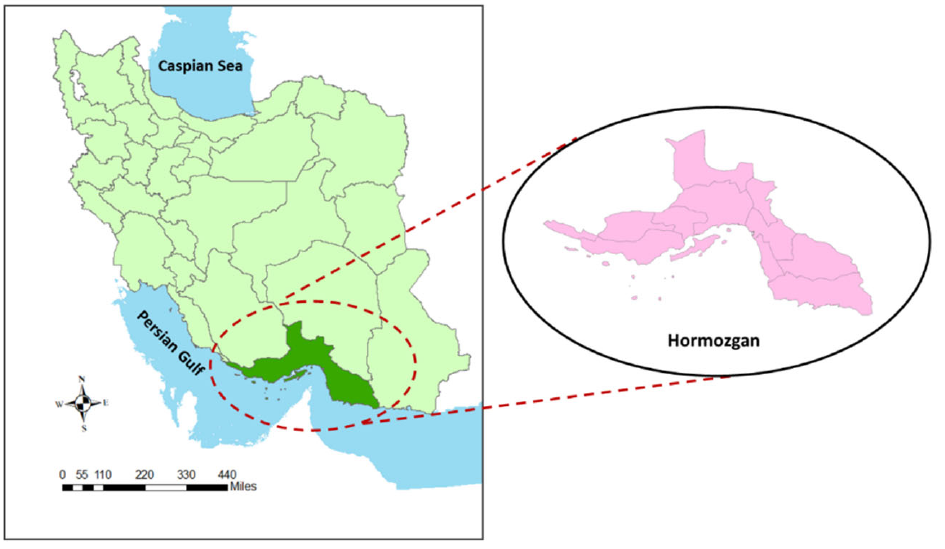
Figure 1. Hormozgan province on a map of Iran.